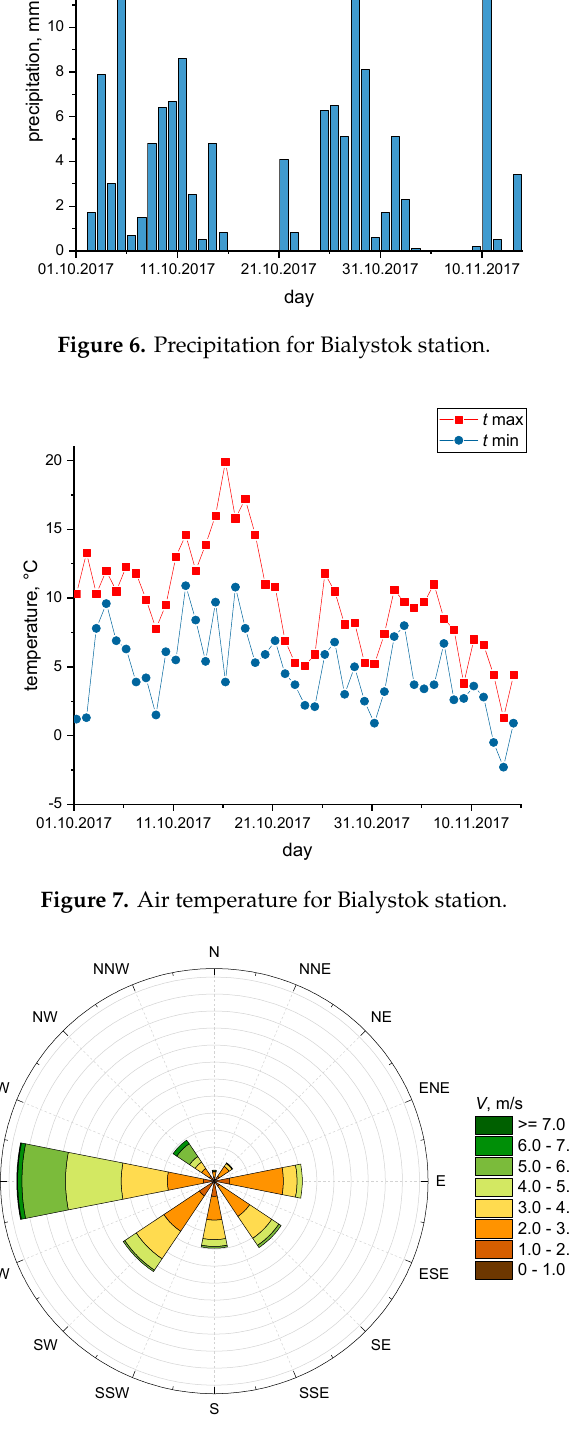
Figure 8. Wind direction for Bialystok station.